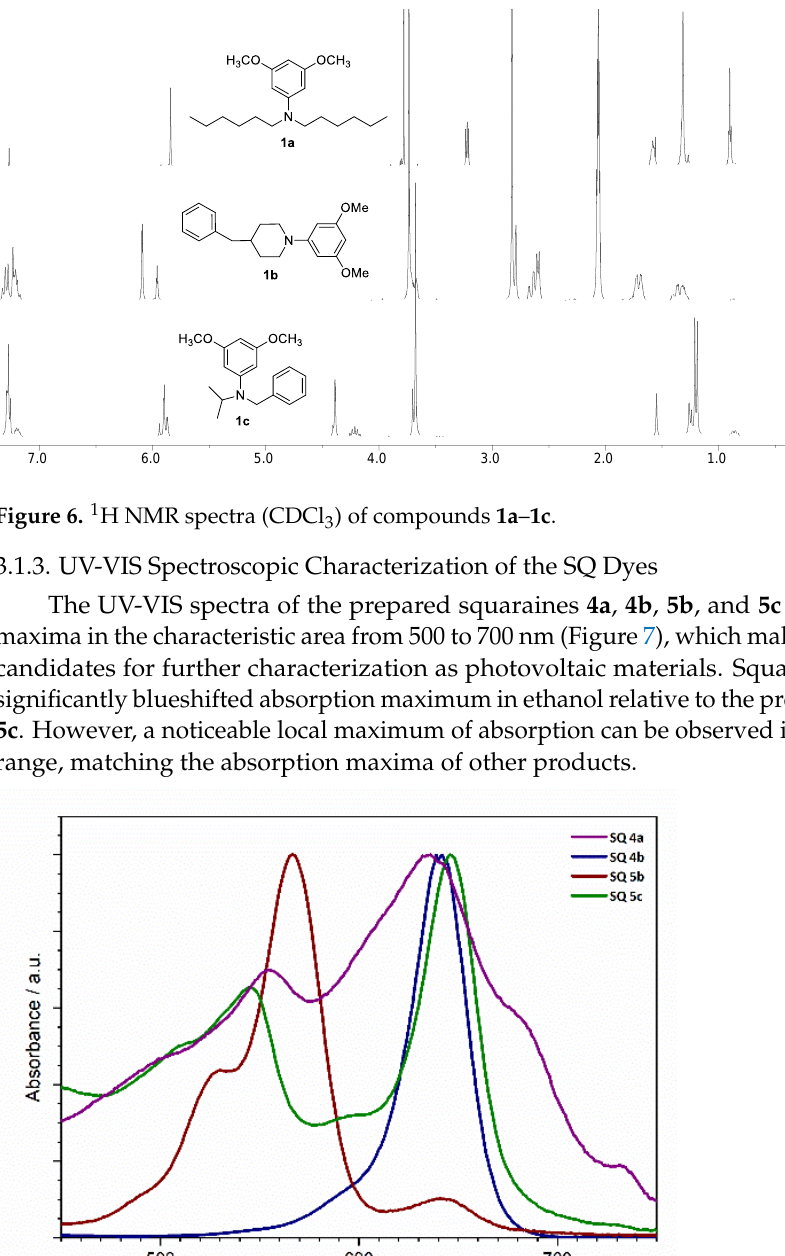
Figure 5. Synthesis of squaraines 4a , 4b , 5b and 5c .